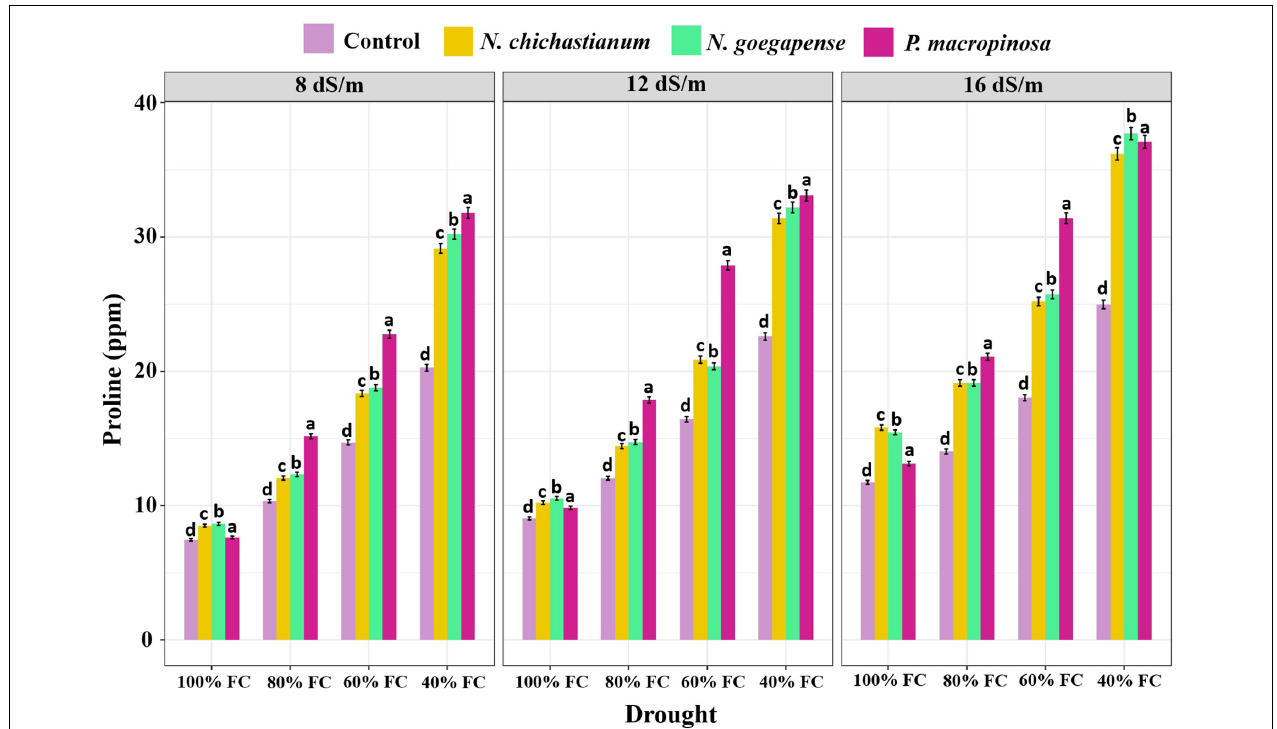
FIGURE 3 | The effects of halotolerant endophytic fungi species on leaf proline content of barley plants, under salinity and drought stress. Different levels of drought stress and different fungal treatment are shown on the horizontal axis and colorful bars, respectively. Various letters on the top of bars display significant differences between mean values of different fungal treatments under the different levels of salinity and drought stress at p ≤